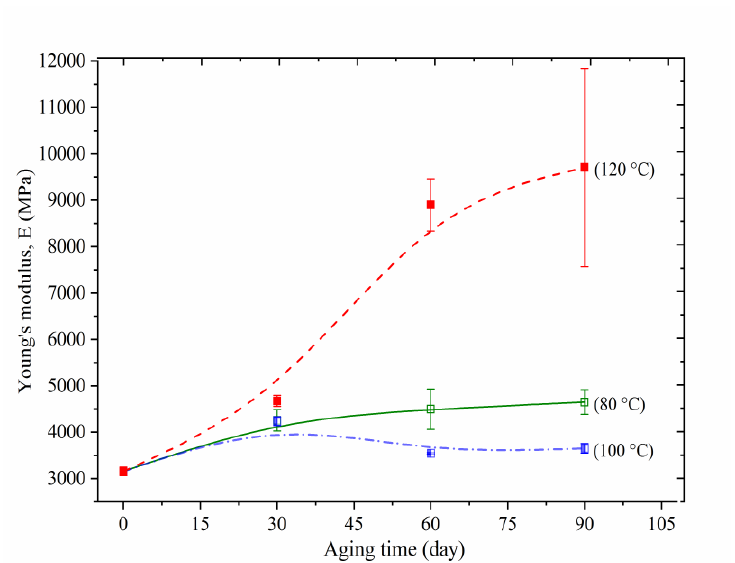
Fig. 2. Evolution of Young’s modulus of (u-PVC) aged at (80, 100 and 120 °C) versus aging